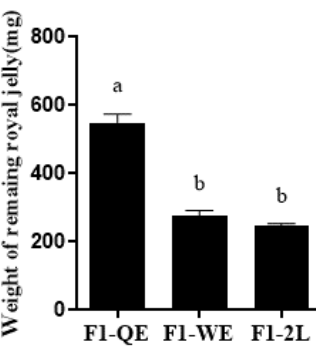
Figure 1. Queen cell length and weight of the remaining royal jelly in queen cells among the three groups. Bars show mean ± SE (standard error). Different letters above the bars indicate significant differences between groups ( p < 0.05, one-way ANOVA test followed with Fisher’s LSD test).